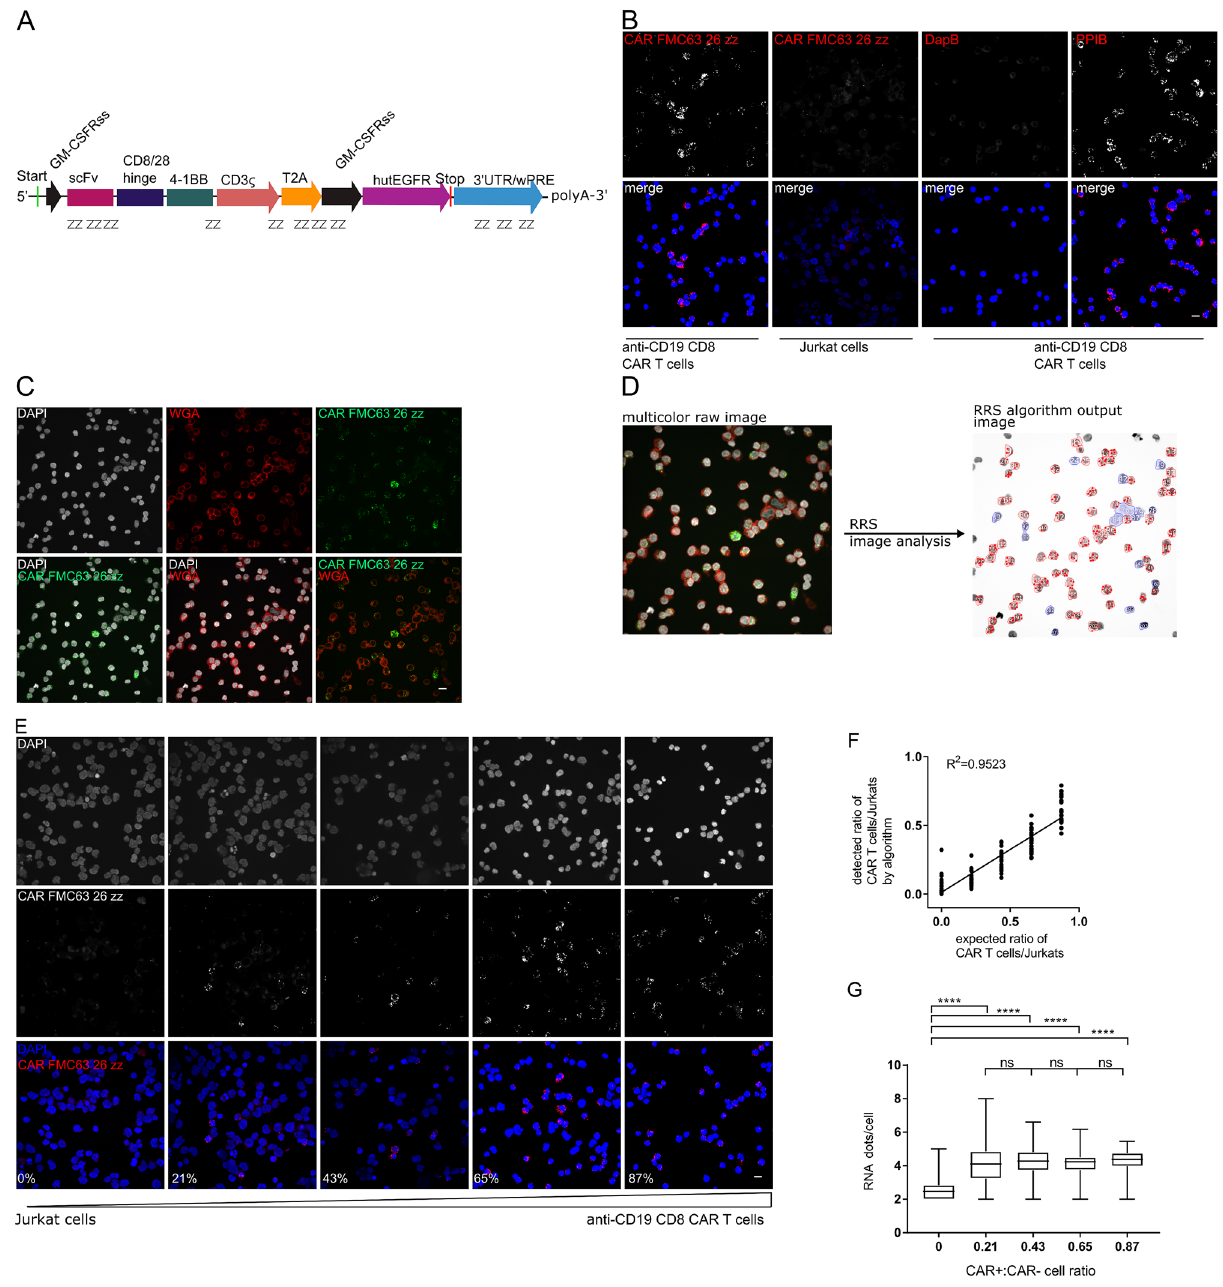
Figure 1. CD19 CAR RNA FISH in vitro validation. The probes for CAR mRNA detection are directed against the scFv and wPRE and bridging areas in the signaling domain of the CAR ( A ). Cytospins of actively growing human anti-CD19 CD8 CAR T cells or Jurkat cells were stained with CAR FMC63 26zz probes or PPIB (+ control) or DapB (-control) probes ( B ). CD19 CAR T cells were stained with CAR FMC63 26zz probes- Alexa488 and Texas red-conjugated wheat germ agglutinin to improve cell segmentation ( C ). RRS analysis of multicolor raw images includes nuclei and RNA detection as well RRS detection of plasma membrane staining ( D ). Fixed human anti-CD19 CD8 CAR T cells and Jurkat cells were mixed at different ratio, processed for cytospins and stained with CAR FMC63 26zz probes-Atto550, Oregon Green 488-conjugated WGA (not shown) and DAPI ( E ). Correlation of CAR+ cells detected by RRS analysis and flow cytometry ( F ). Comparison of RNA dots/cells between different dilution steps. Statistics are calculated by one-way ANOVA with Tukey’s multiple comparison test ( G ). Staining experiments were performed at least 3 times with technical duplicates. Scale bar = 10